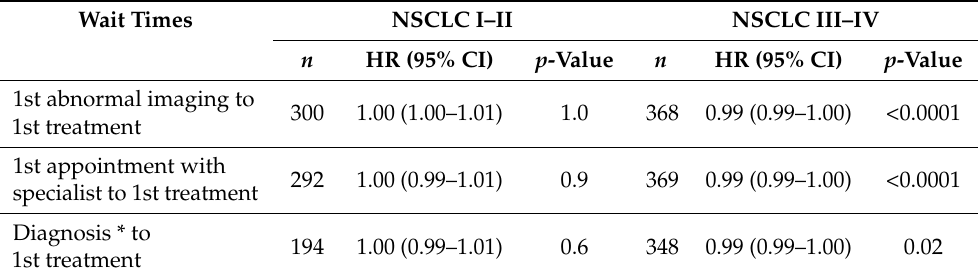
Table A3. Wait times and overall survival, NSCLC stages I–II versus